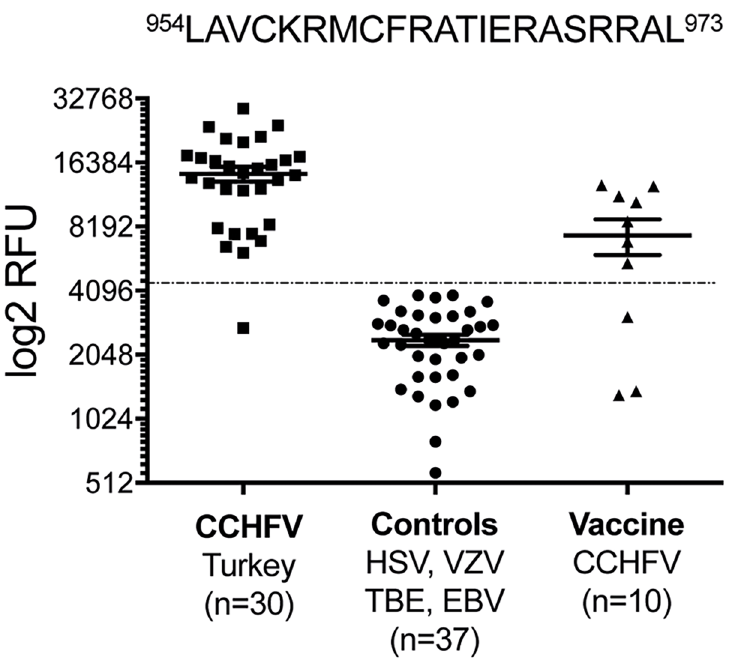
Fig 3. Dot-plot of intensities of the selected peptide EWP 83 (p96 + 3 aa, 954 LAVCKRMCFRATIEASRRAL 973 ) after serology. This includes sera from Turkish CCHFV survivors, control sera from individuals infected with other viral pathogens as controls and Bulgarian individuals vaccinated against CCHFV. The dotted line represents the diagnostic cut-off value determined from mean of the control group plus two standard deviations. P <